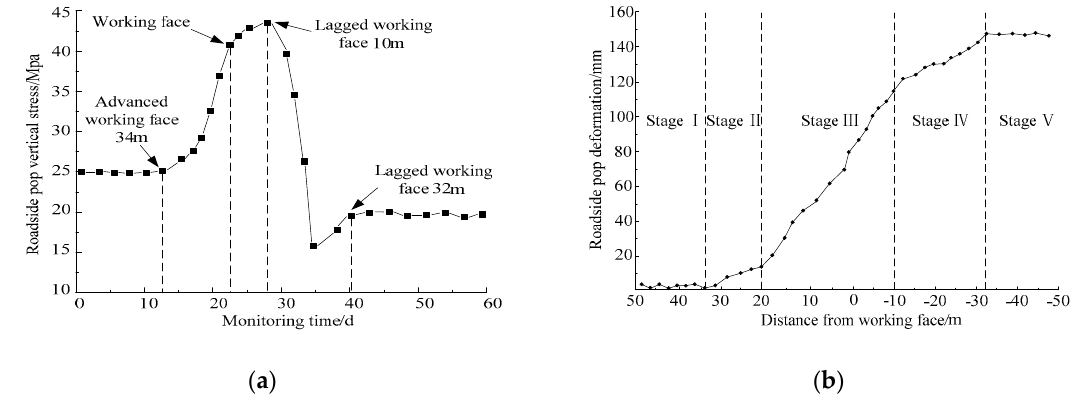
Figure 18. Roadside prop monitoring curves. ( a ) Vertical stress monitoring curve; ( b ) Deformation monitoring curve.